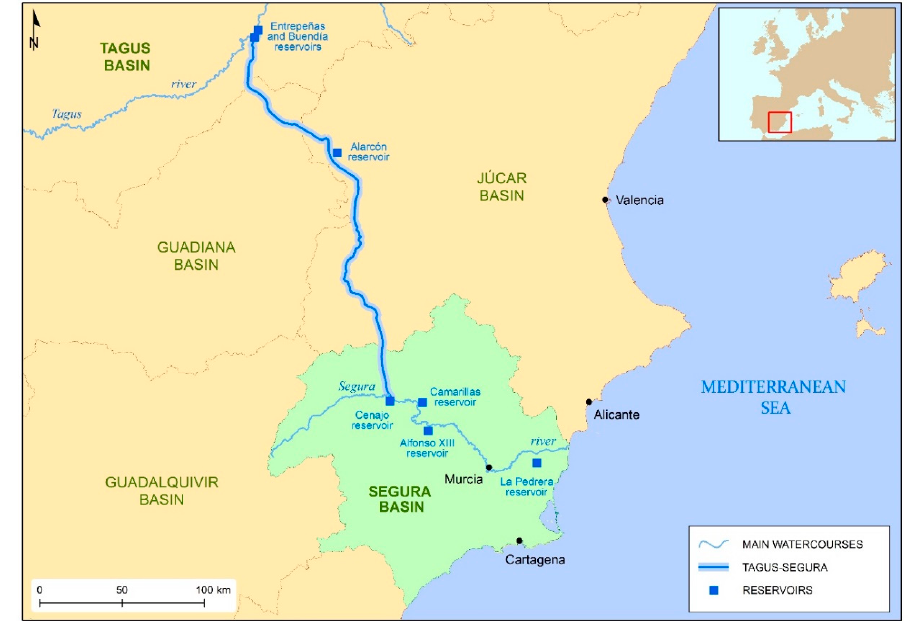
Figure 2. Routing of the tracing of the Tagus-Segura Aqueduct and main reservoirs of the Segura River Basin (own elaboration).